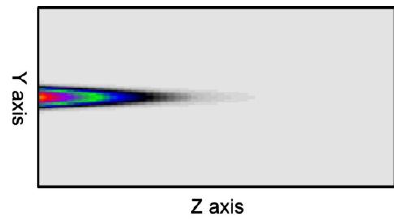
Figure 18. Core mode power propagation pattern on the Y–Z plane under the conditions of Λ SFBG = 0.5371029 μm and duty cycle = 10%.